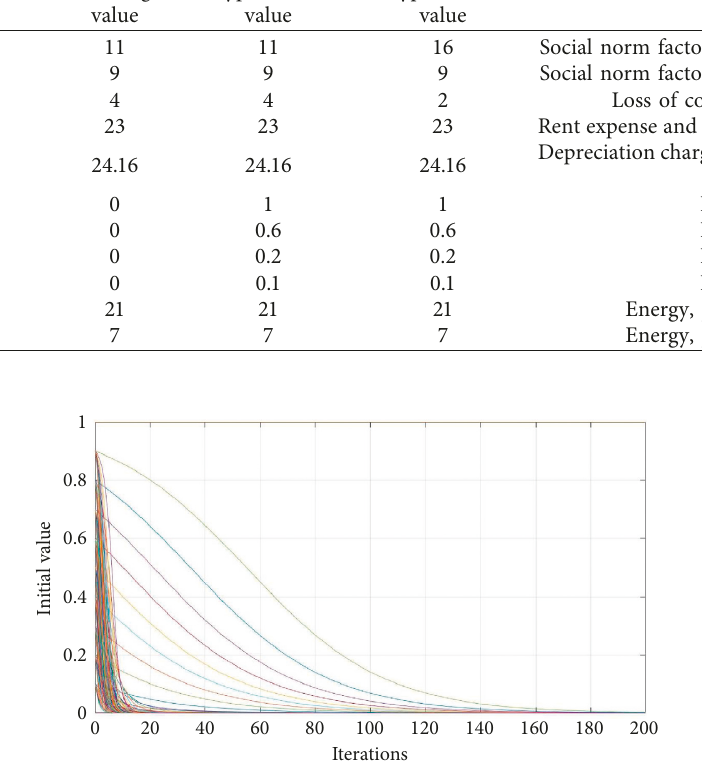
Figure 6: dx / dt − t in hypothesis 1 value under different initial values.